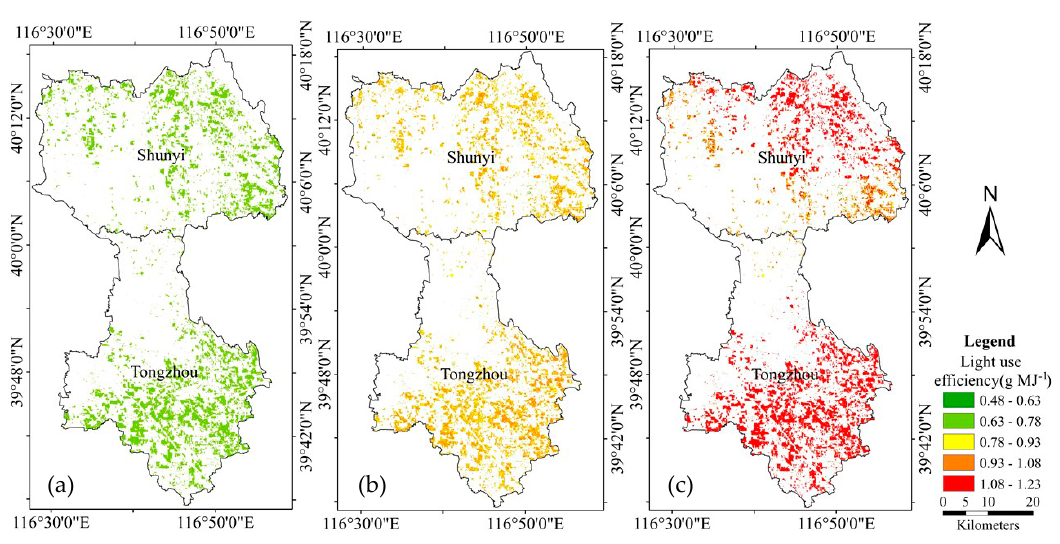
Figure 4. Spatial distribution of light use e ffi ciency of winter wheat from March to May 2009: ( a ) March; ( b ) April; ( c ) May.